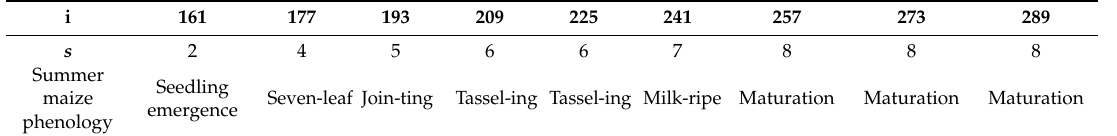
Table 3. The corresponding values of i , s , and summer maize